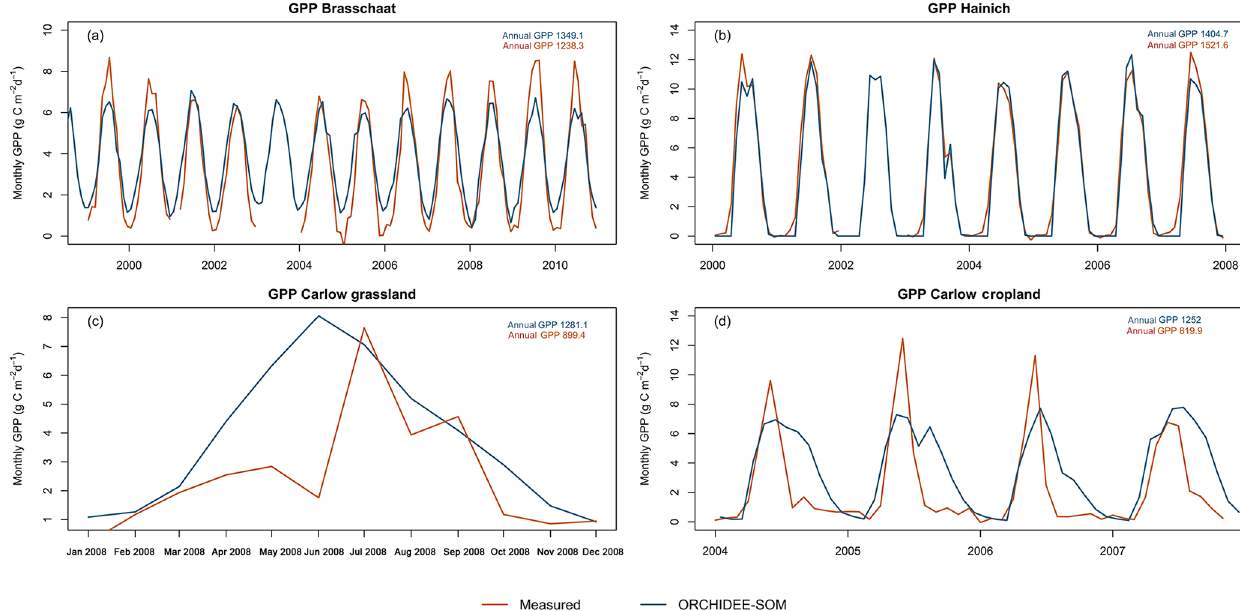
Figure 2. Measured and modeled daily GPP (monthly means) at the four sites after GPP optimization: (a) Brasschaat forest, (b) Hainich forest, (c) Carlow grassland, and (d) Carlow cropland. Measured GPPs are acquired from each FLUXNET site and modeled GPP was acquired using